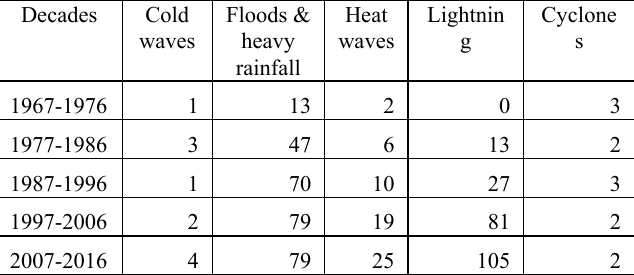
Table.1 Annual Average number of different extreme events